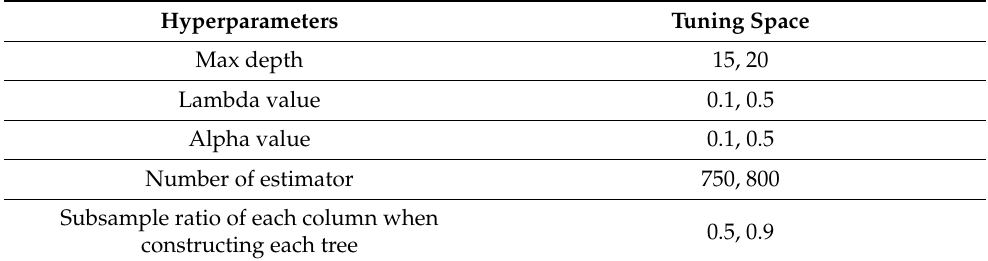
Table 6. Tuning Space for Hyperparameters in the XGBoost